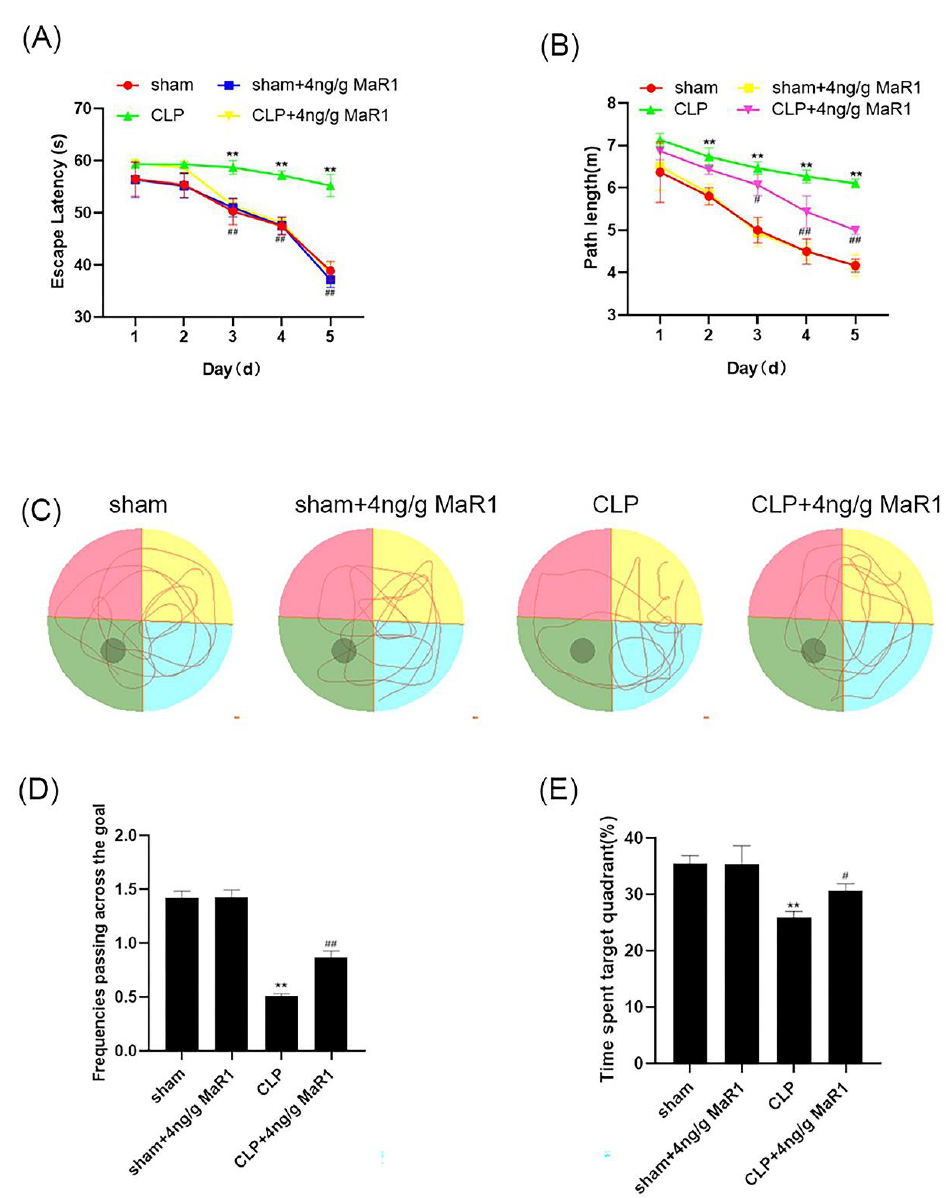
Figure 2. Four ng/g of MaR1 ameliorated learning and memory impairment in CLP rats: ( A , B ) eva- sion latency and path length of each group of rats were measured by a MWM test; 4 ng/g MaR1 shortened the distance and time for CLP rats to escape the incubation period; ( C ) representative swim- ming trajectory maps in space exploration experiments. Compared with CLP rats, rats spent more time in the third quadrant after 4 ng/g MaR1 treatment; ( D , E ) frequency of passage and time spent in the target quadrant during exploration trials. Data are expressed as mean ± SD ( n = 10/group); ** p < 0.01, compared to the Sham group; # p < 0.05, ## p < 0.01, compared to the CLP